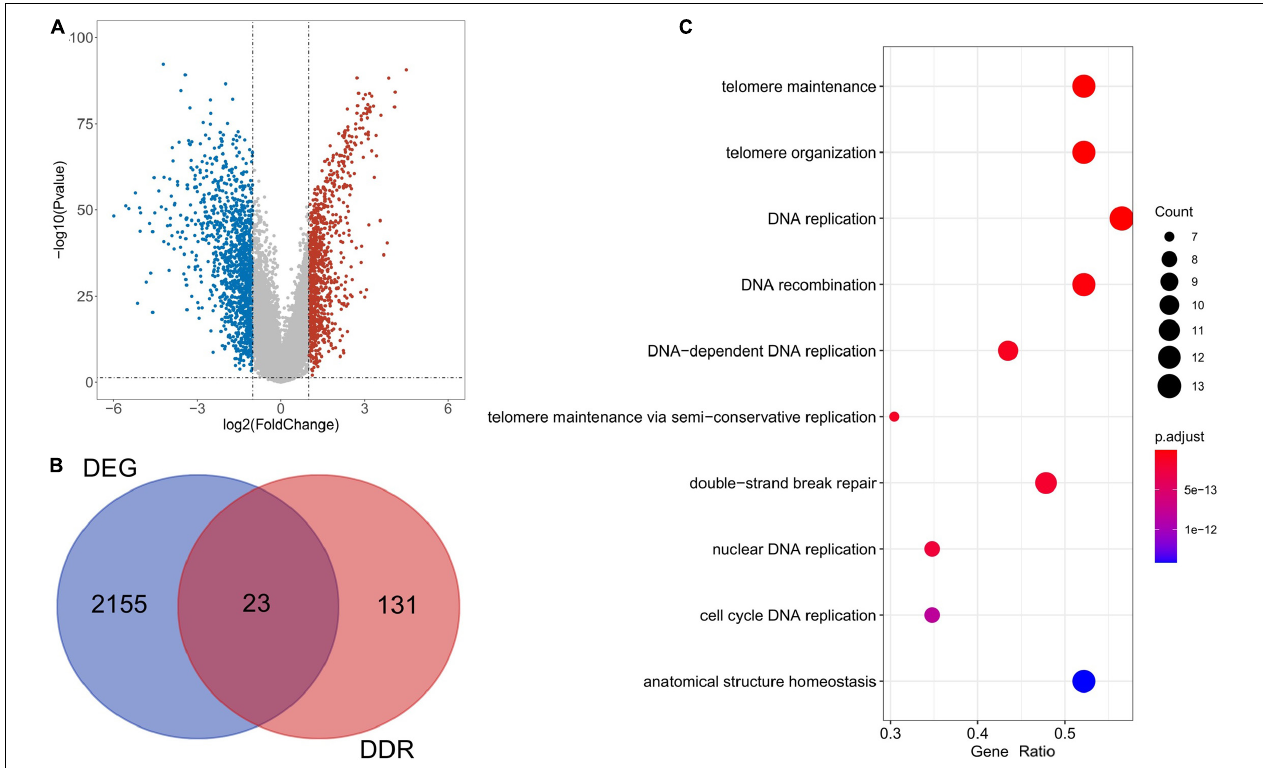
FIGURE 1 | Bioinformatics analysis of the expression of DE-DDRs. (A) A Volcano plot illustrating the comparison of differential gene expression in tumors vs. normal tissue. The red dots indicate that the gene expression level is up-regulated (tumor samples relative to normal samples), the blue dots indicate that the gene expression level is down-regulated (tumor samples relative to normal samples), and the gray dots indicate that there is no significant difference between these genes. (B) A Venn diagram representation showing the intersection of DDRs and DEGs. (C) The results of the GO annotation of